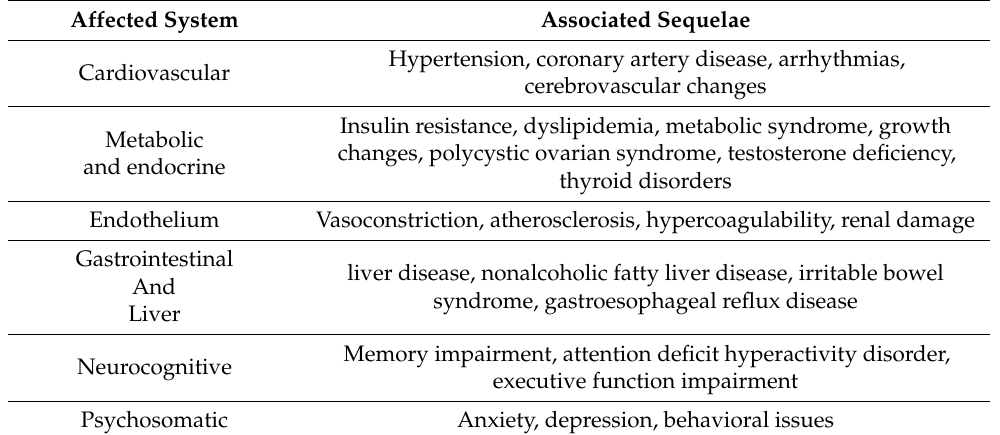
Table 1. Sequelae linked to or complicated by poorly managed obstructive sleep apnea. The table lists a few affected systems in individuals with untreated OSA and specifies a few associated sequelae of the respective